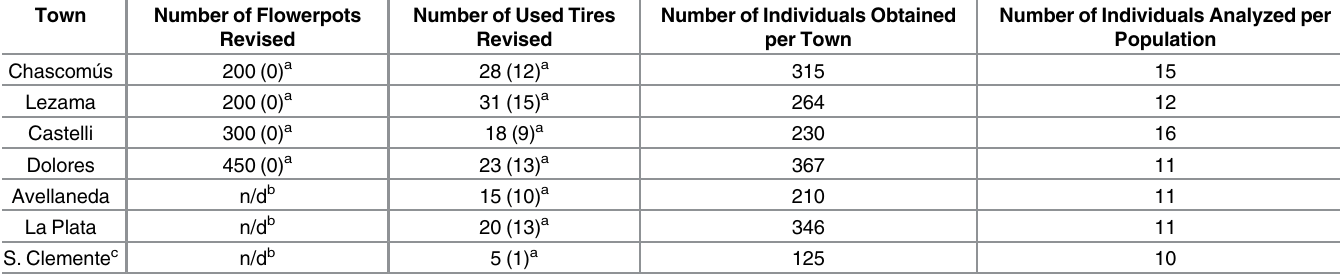
Table 1. Sampling stations and specimens of A . aegypti